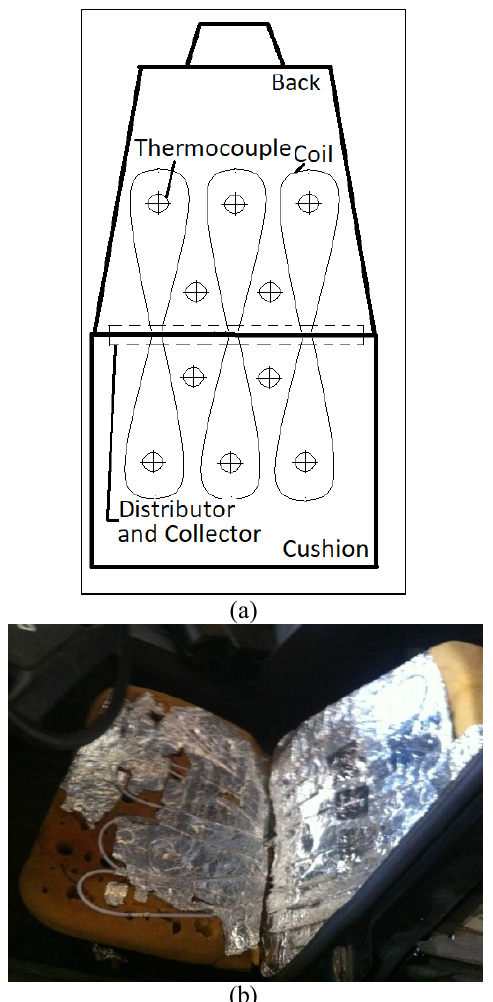
Fig. 1. Modified vehicle seat (a) schematic view (b) photograph taken after the